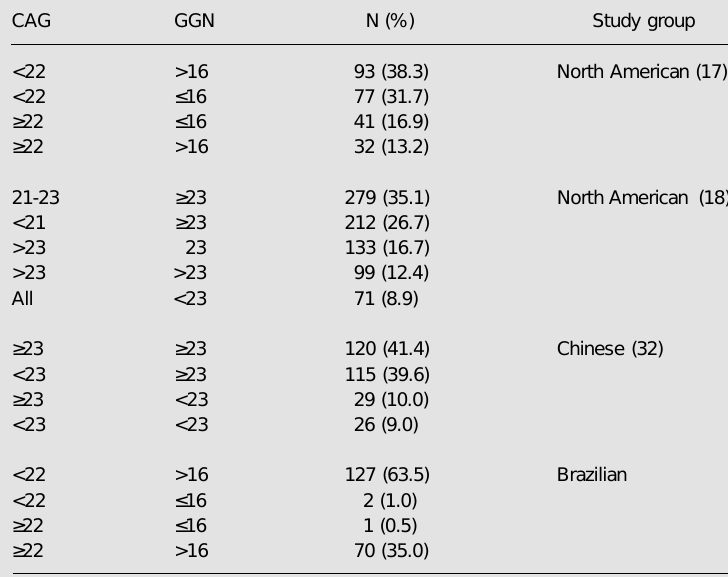
Table 4. Prevalent combined numbers of CAG and GGN repeats of the AR gene in different populations.